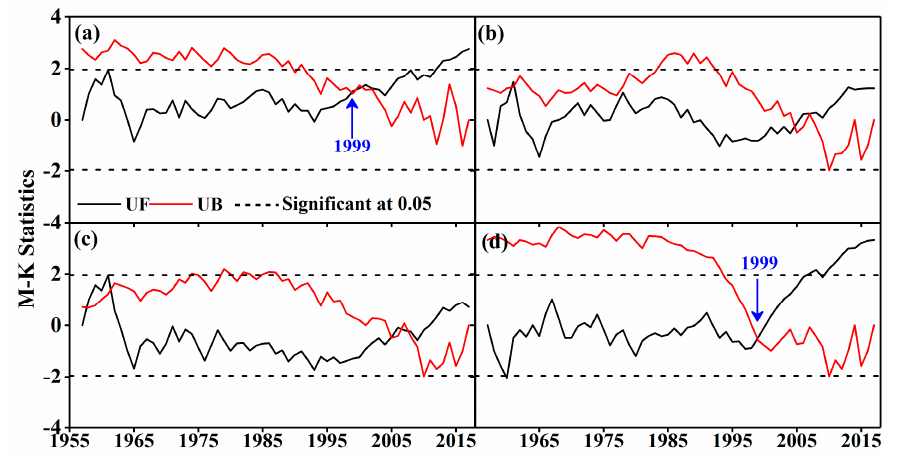
Figure 12. M–K change point test of annual runoff depth in the ( a ) YRK, ( b ) KRK, ( c ) YUK, and ( d ) KRY in 1957–2017.